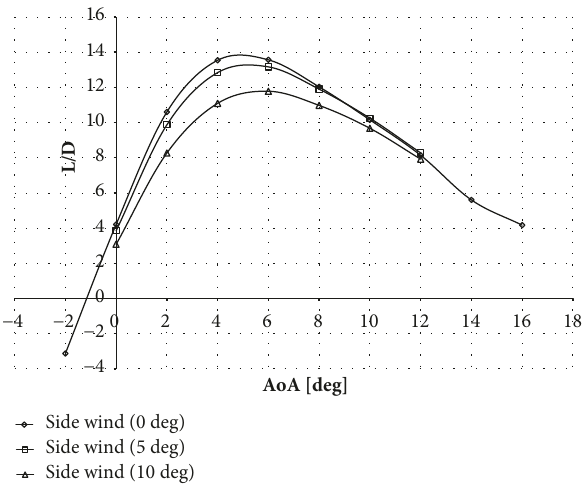
Figure 11: Impact of the side wind onto lift to drag ratio for the final UAV design (Re = 237